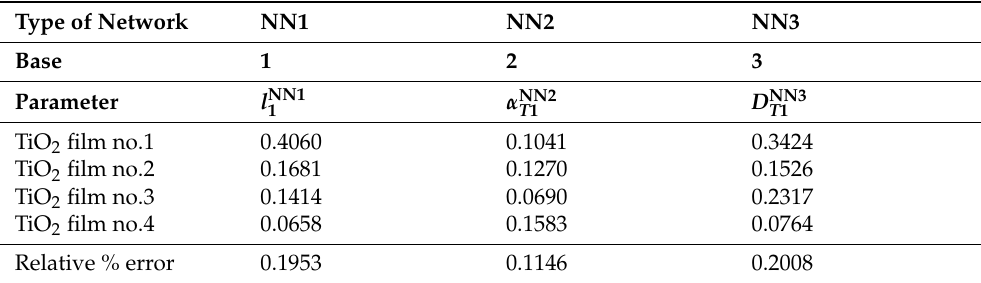
Table 2. Relative (%) error prediction of TiO 2 thin-film parameters on 4 test photoacoustic signals that are in step by NN1, NN2 and NN3 networks.